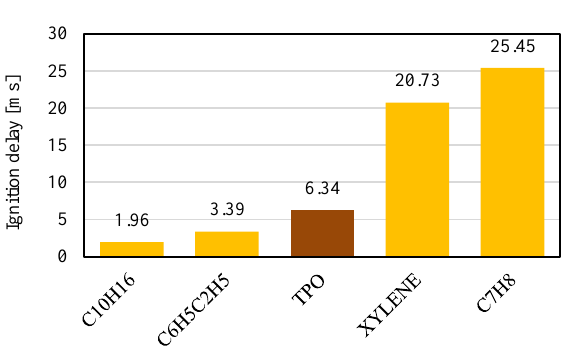
Fig. 24. Ignition delay of all compounds of TPO